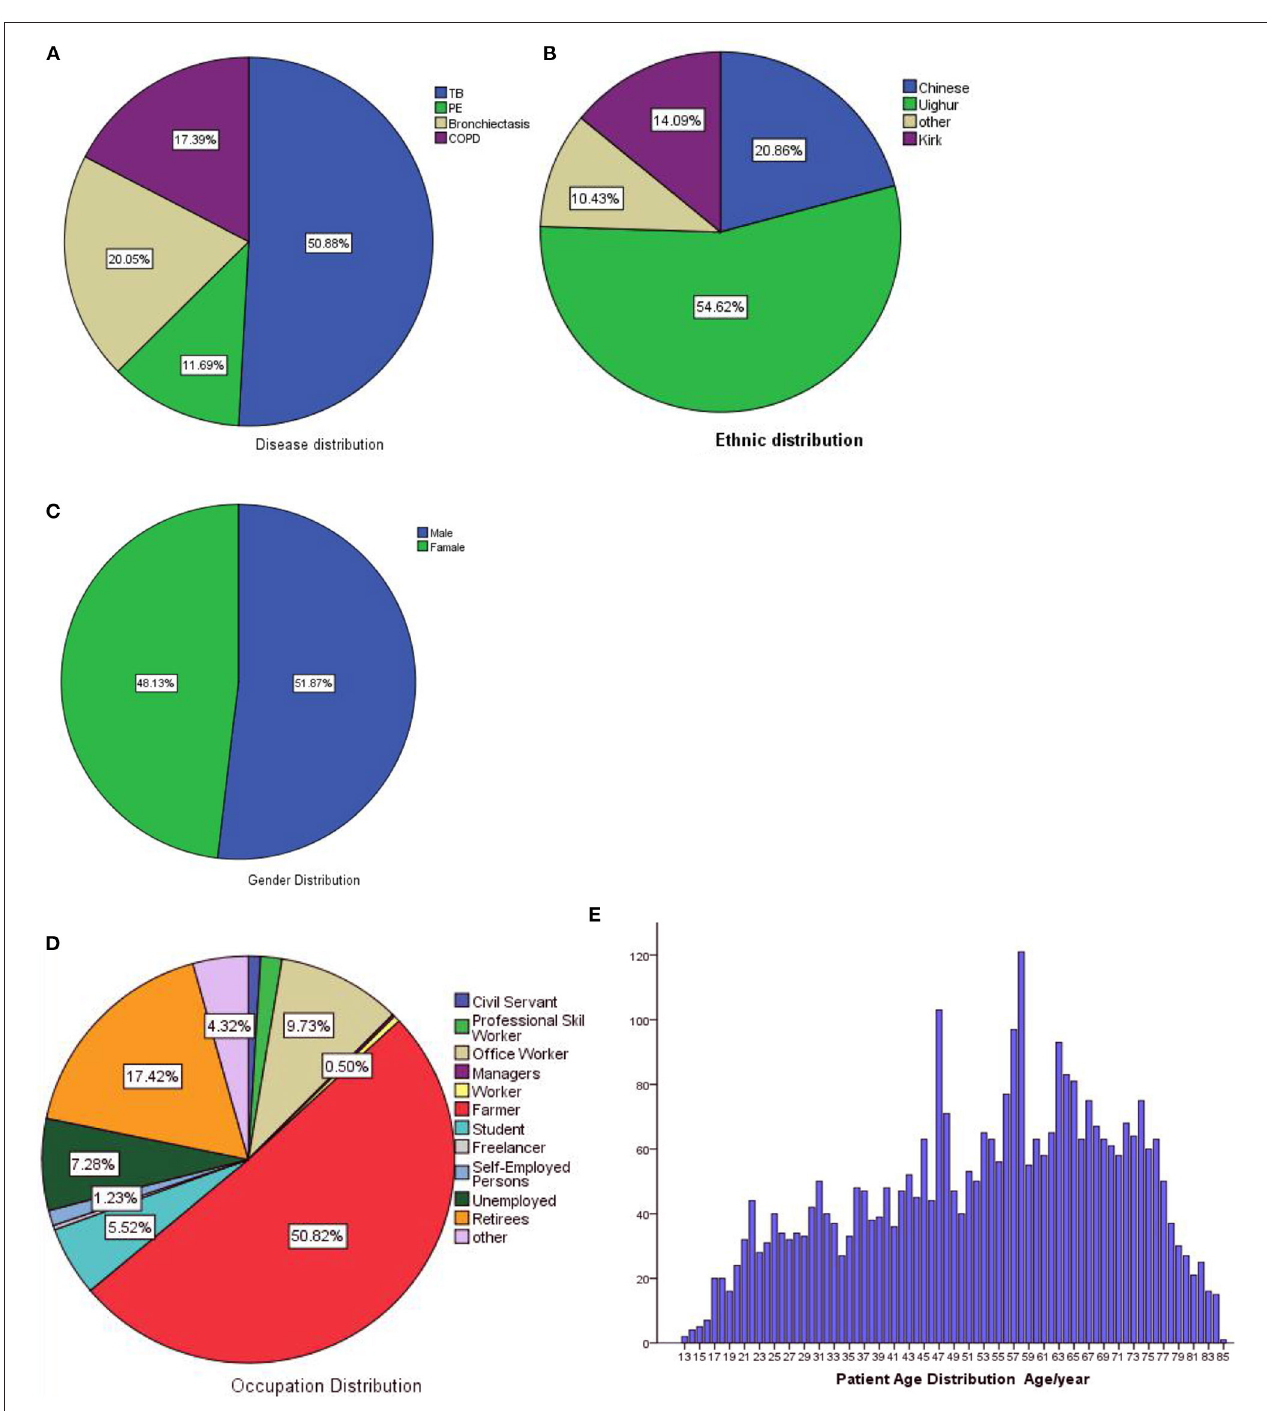
FIGURE 7 | Dataset statistics. (A) Disease distribution, (B) ethnic distribution, (C) gender distribution, (D) occupation distribution, (E) age distribution.